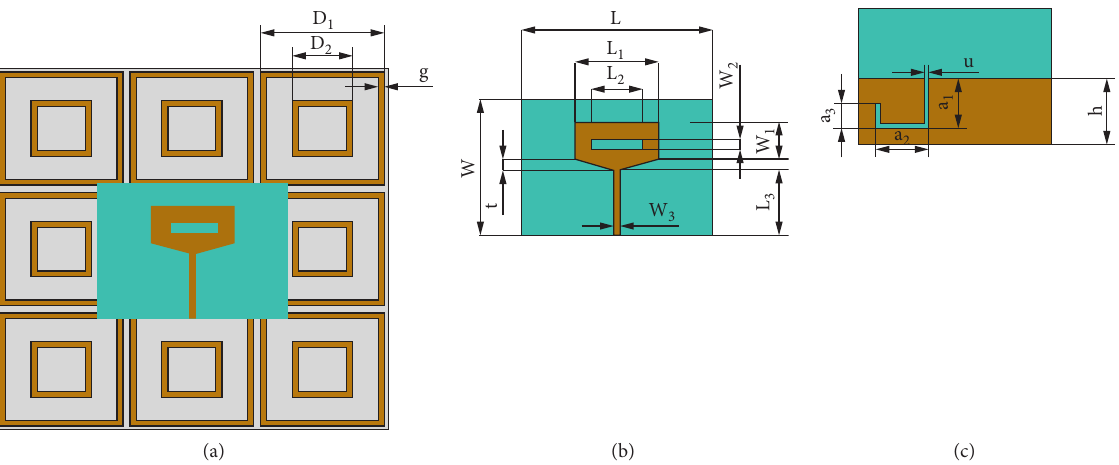
Figure 1: Configuration of the funnel-shaped antenna system: (a) global view, (b) front view, and (c) back